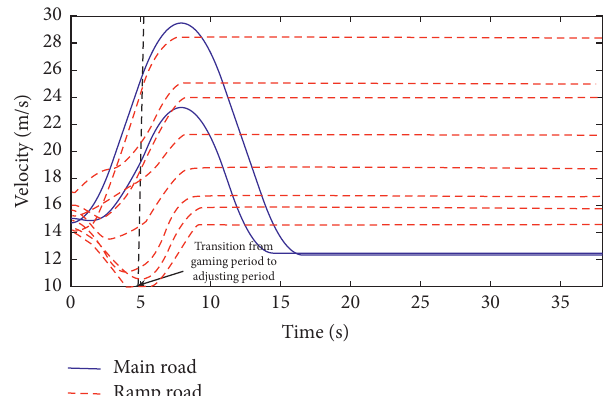
Figure 11: Velocity of vehicles for Case Study 2.